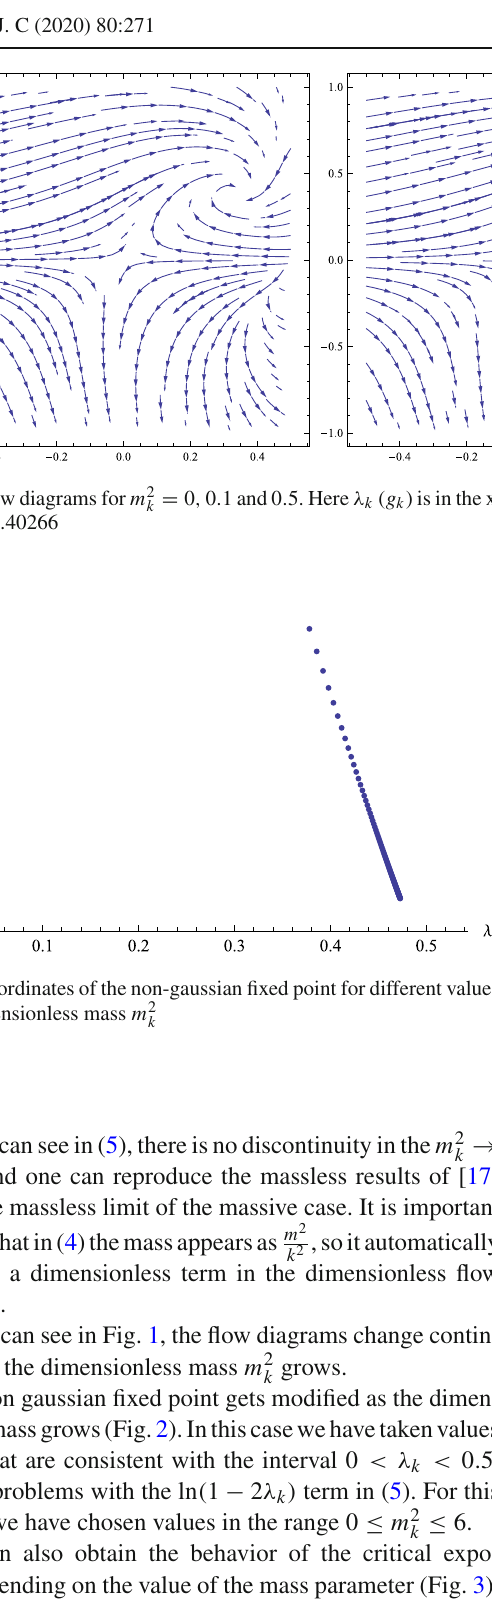
= 0 fixed point are given by λ